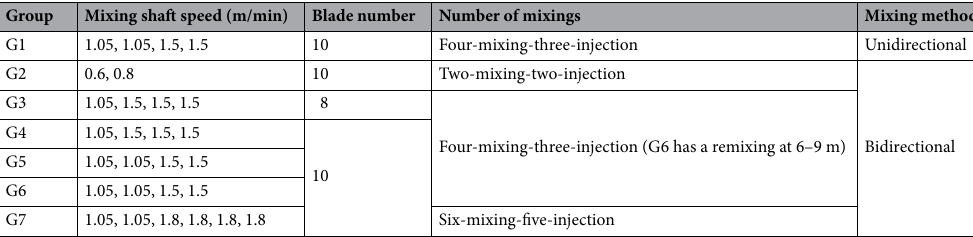
Table 4. Construction parameters of DSM